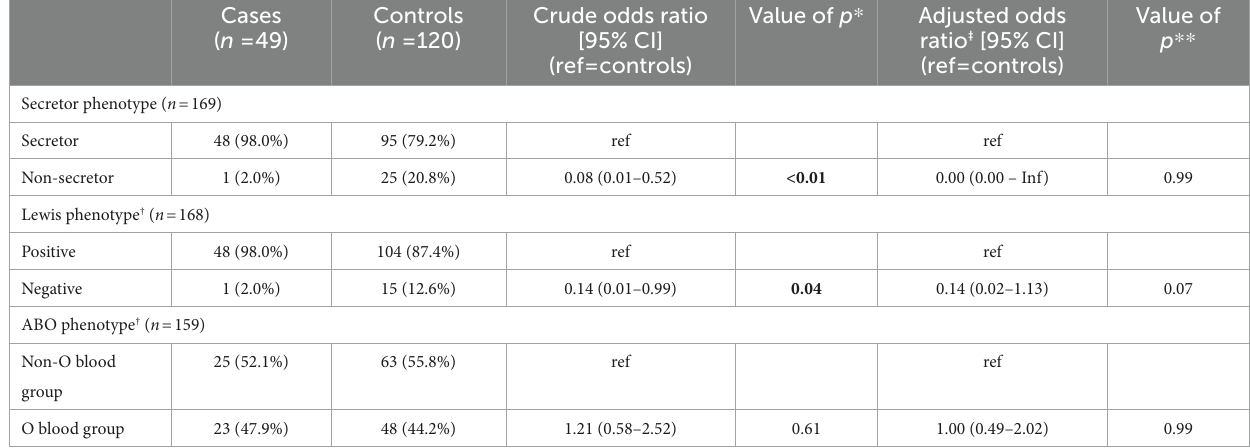
TABLE 5 Crude and adjusted logistic regression analysis shows impact of FUT2 and FUT3 polymorphisms between cases and controls in Cayenne.